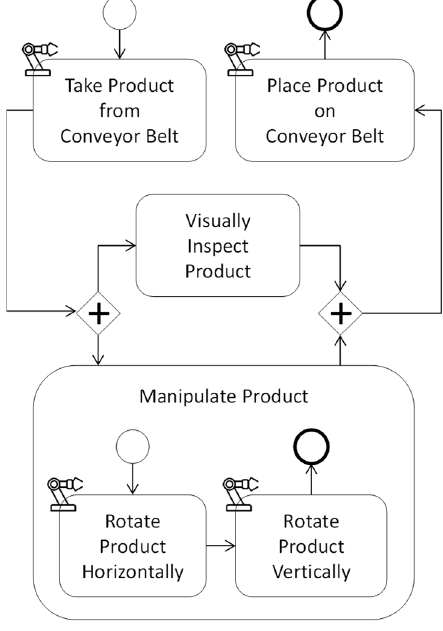
Figure 7. Fragment of manufacturing process